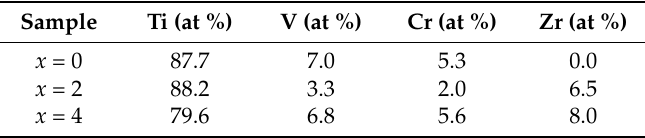
Table 5. EDX analysis showing the elemental composition at point 4 of: Ti 1 V 0.9 Cr 1.1 + x wt % Zr alloys for x = 0, 2, and